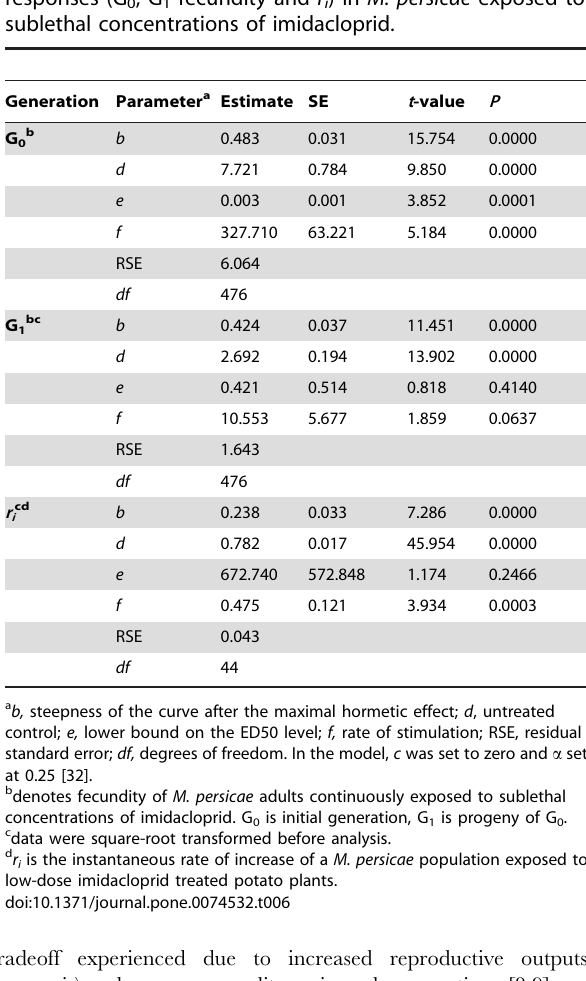
Table 6. Regression parameters of model-fitting hormetic responses (G 0 , G 1 fecundity and r i ) in M. persicae exposed to sublethal concentrations of imidacloprid.